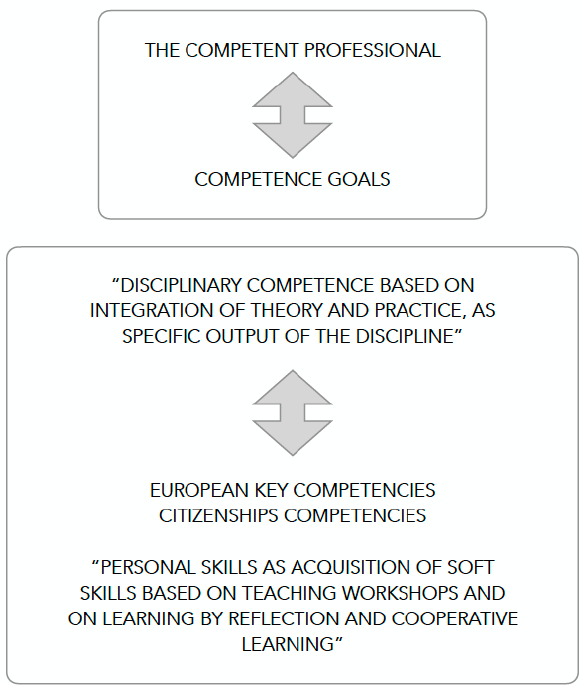
Figure A1. Guidelines to the structure and planning of the curriculum to train a competent professional in physical education.